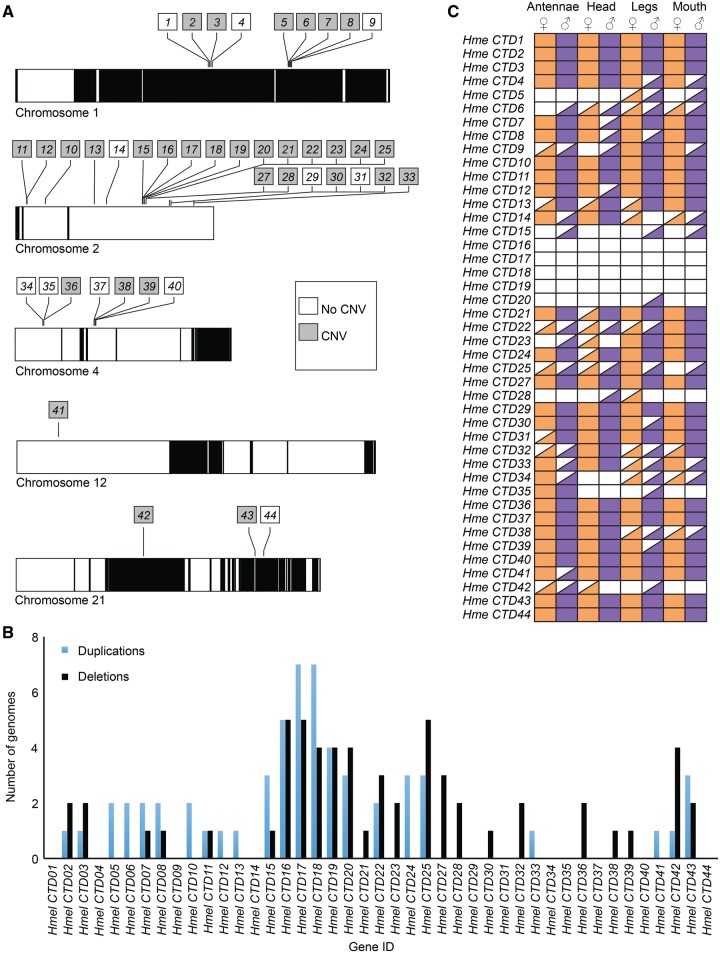

—CRAL-TRIO domain gene location, copy number variation, and mRNA presence patterns. (A) CRAL-TRIO domain genes are located on five chromosomes, many in tandem. Alternating black and white chromosomal regions represent scaffolds. Shaded squares represent genes with copy number variation, duplicated and/or deleted in at least 1 of 18 resequenced genomes. (B) Number of genomes in which CRAL-TRIO domain genes are deleted (black) or duplicated (blue) in 18 Heliconius melpomene resequenced genomes. (C) mRNA presence patterns of CRAL-TRIO domain genes in H. melpomene male and female antennae, head, legs, and mouth parts. Filled square represents complete presence (>1 TPM for all replicates), half-filled square represents partial presence (>1 TPM for at least one replicate but not all four), and no fill represents lack of transcript mRNA.